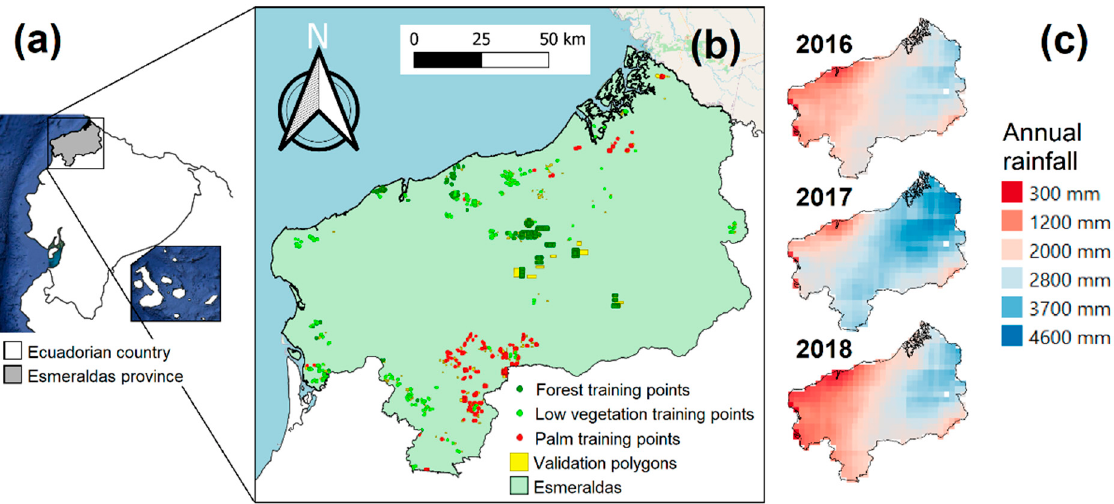
Figure 1. Delimitation of the area of study, comprising the Esmeraldas province ( b ), which is situated in the north of the coastal region of the Ecuadorian Republic ( a ). The central image shows the distribution of the sample points from which the spectral information is extracted to use it in the classifier. ( c ) Annual rainfall of the area of study during the years 2016, 2017, and 2018. Fluctuations among years are observed. Rainfall data retrieved from the Climate Hazards Group InfraRed Precipitation with Station (CHIRPS) dataset [35].